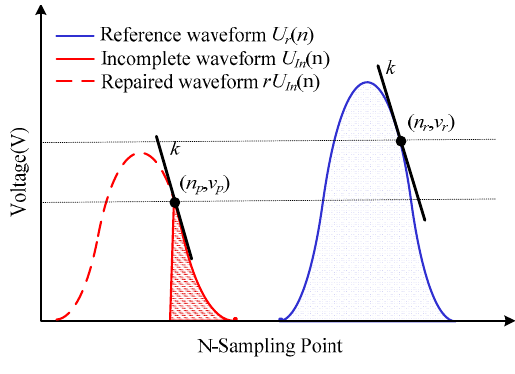
Figure 7. Incomplete waveform repair.